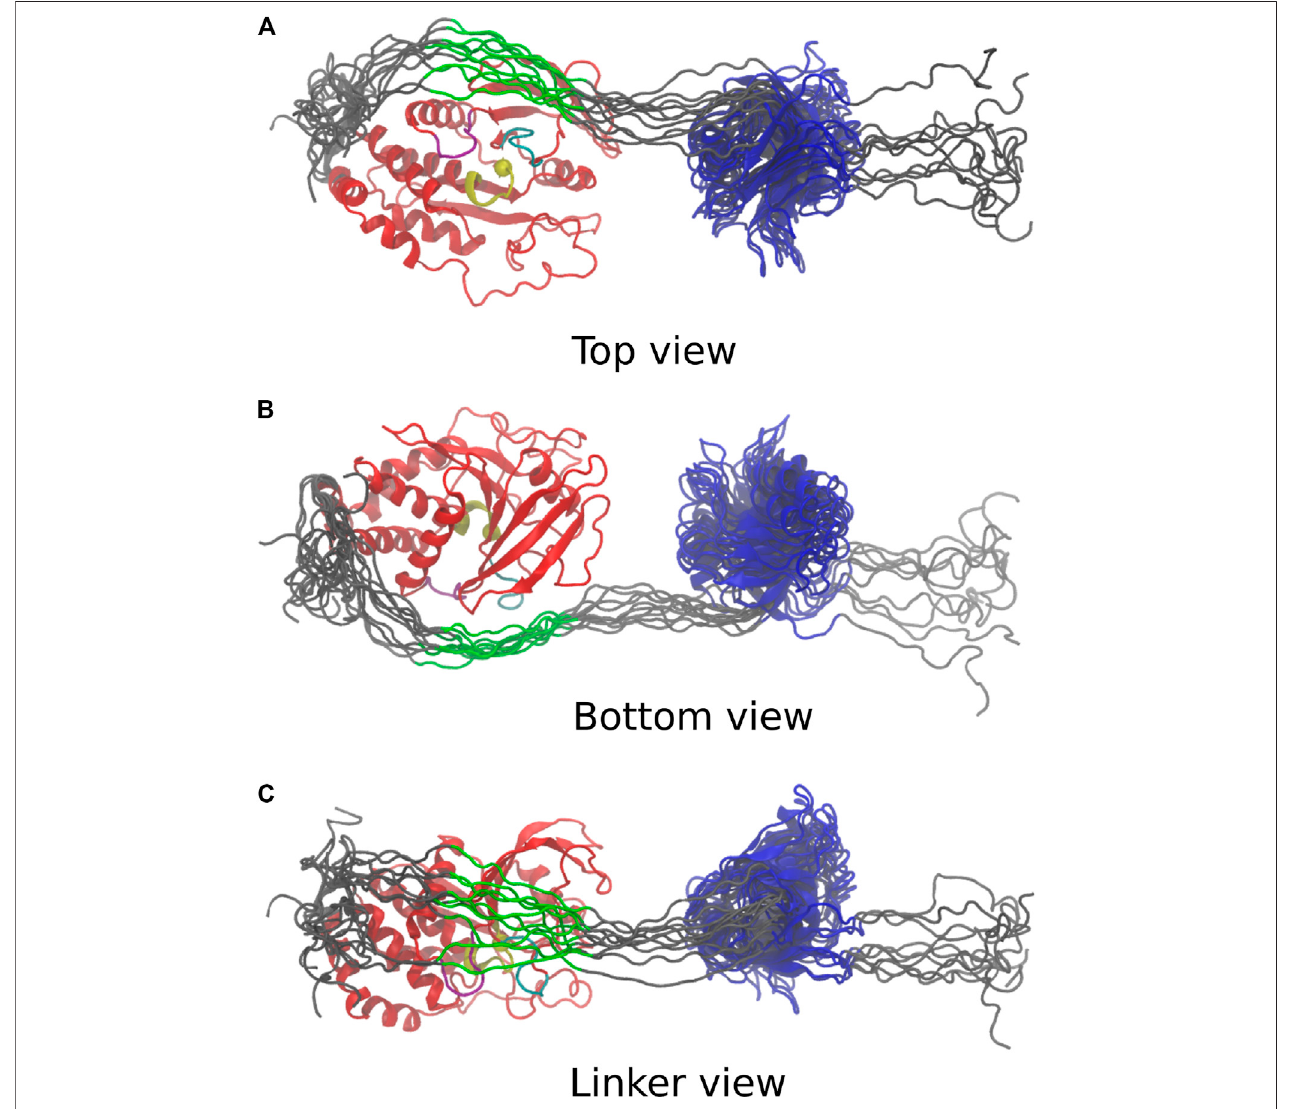
FIGURE 4 | Last frame of the top 10 simulations, aligned on the PTP domain. PTP: red; PTP loop and catalytic cytosine [H (851)CSAGIGRT (859)]: yellow; WPD loop [W (818)PDHGVP(824)]: purple; β 5-loop- β 6 region [T (754)QVERGRV (761)]: cyan; C-terminus, N-terminus and linker: grey; highly conserved linker region [E (617) PDFQYIP(624)]: green; PDZ:blue. (A) Topviewdepictscatalytic site invicinity tothelinker. (B) Bottom viewadopts same orientationas Figure 3 . (C) Linkerview shows conformational variability of